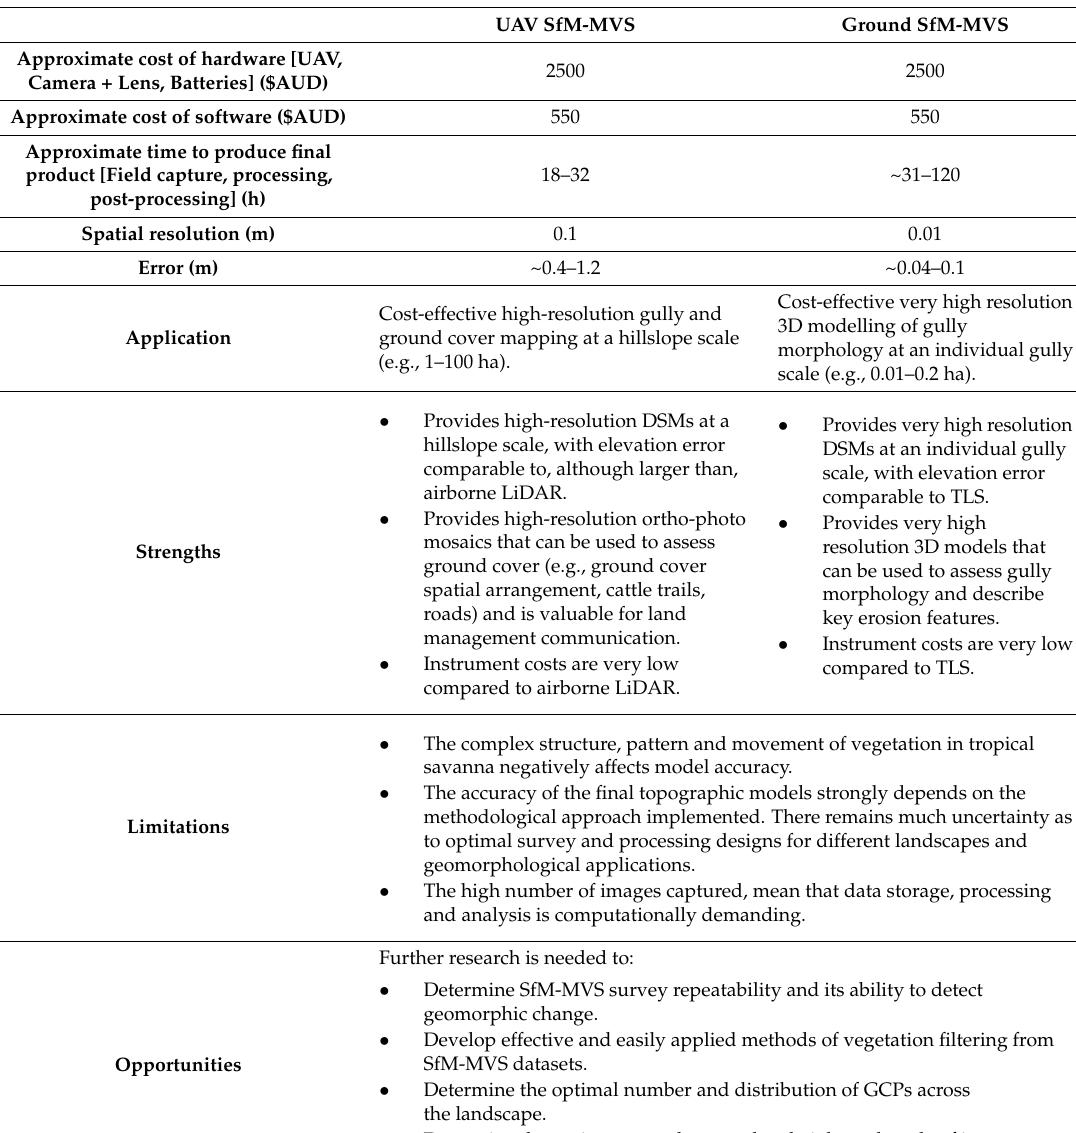
Table 7. Comparison of the time and resource requirements and the strengths and limitations of UAV vs. ground SfM-MVS, and opportunities for further research, as demonstrated in this study. UAV